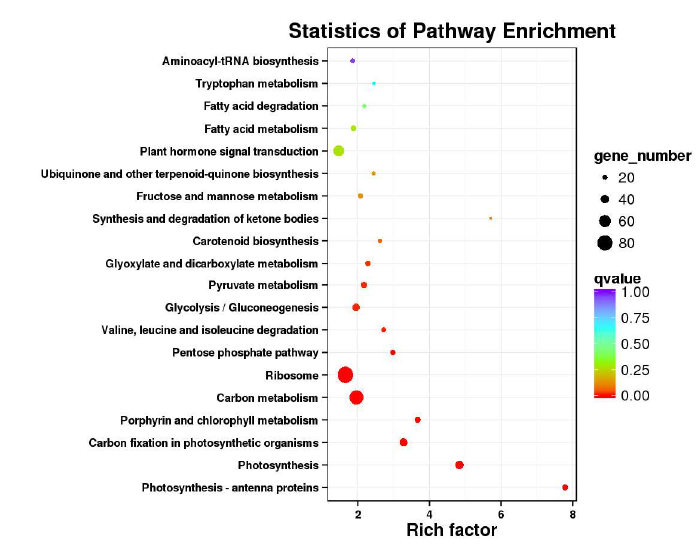
Figure 5. KEGG pathway enrichment analysis of the differentially expressed genes (DEGs). The sub-figures show the most significantly enriched pathways in ( A ) TC_TD; ( B ) SD_TD; and ( C ) SC_SD experimental comparisons, based on the hypergeometric test. The significance of the enrichment of the KEGG pathway is based on the Student’s t -test, q < 0.01. The color gradient represents the size of the q value; the color is from red to blue, and the nearer the red represents the smaller the q value, and the higher the significant level of enrichment of the corresponding KEGG pathway. The “rich factor” shows the ratio of the number of the DEGs to the total gene number in certain pathways.